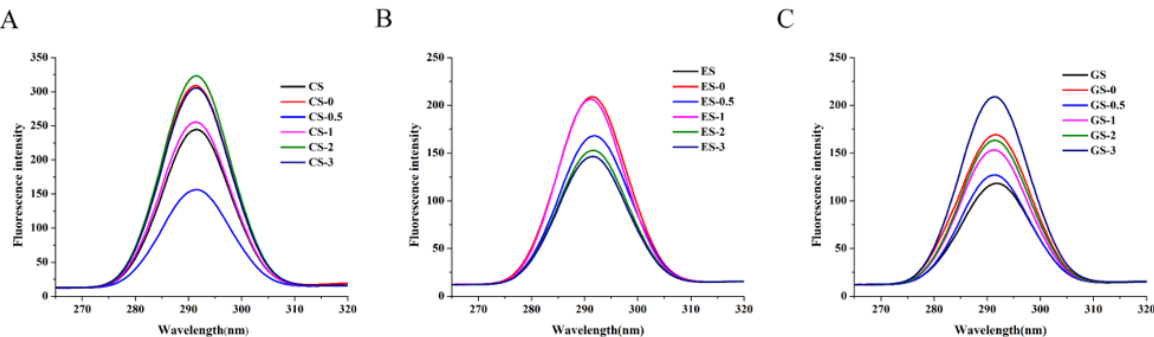
Figure 3. Endogenous fluorescence spectrum of fish gelatin. ( A ) CS, CS-0, CS-0.5, CS-1, CS-2, CS-3: CS gelatin, CS gelatin phosphorylated by STMP for 0, 0.5, 1, 2 and 3 h, respectively. ( B ) ES, ES-0, ES- 0.5, ES-1, ES-2, ES-3: ES gelatin, ES scale gelatin phosphorylated by STMP for 0, 0.5, 1, 2 and 3 h, respectively. ( C ) GS, GS-0, GS-0.5, GS-1, GS-2, GS-3: GS gelatin, GS gelatin phosphorylated by STMP for 0, 0.5, 1, 2 and 3 h, respectively.